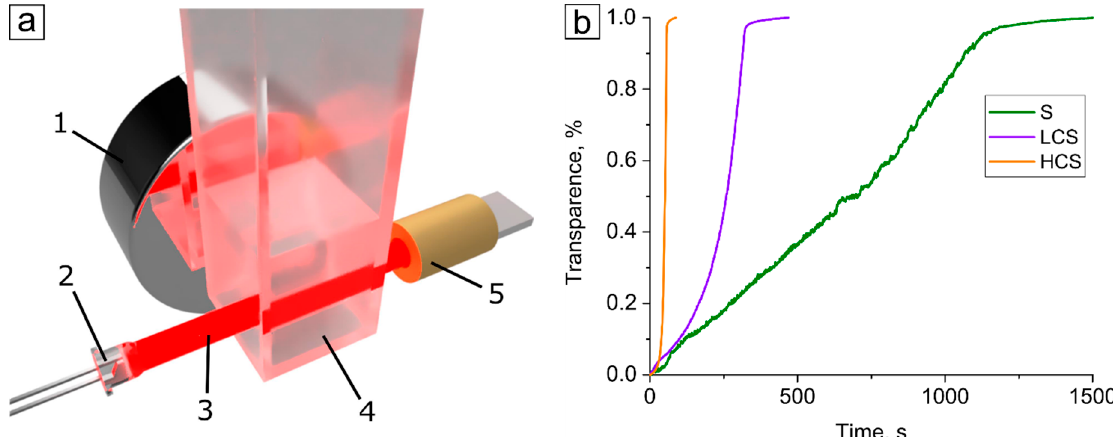
Figure 4. Photosedimentometry of submicron core–shells in water during the time: ( a ) The experimental setup, where 1—permanent magnet, 2—phototransistor, 3—laser beam, 4—cuvette with core–shell suspension, 5—semiconductor laser; ( b ) time dependence of the core–shell suspension transparency in an external magnetic field.